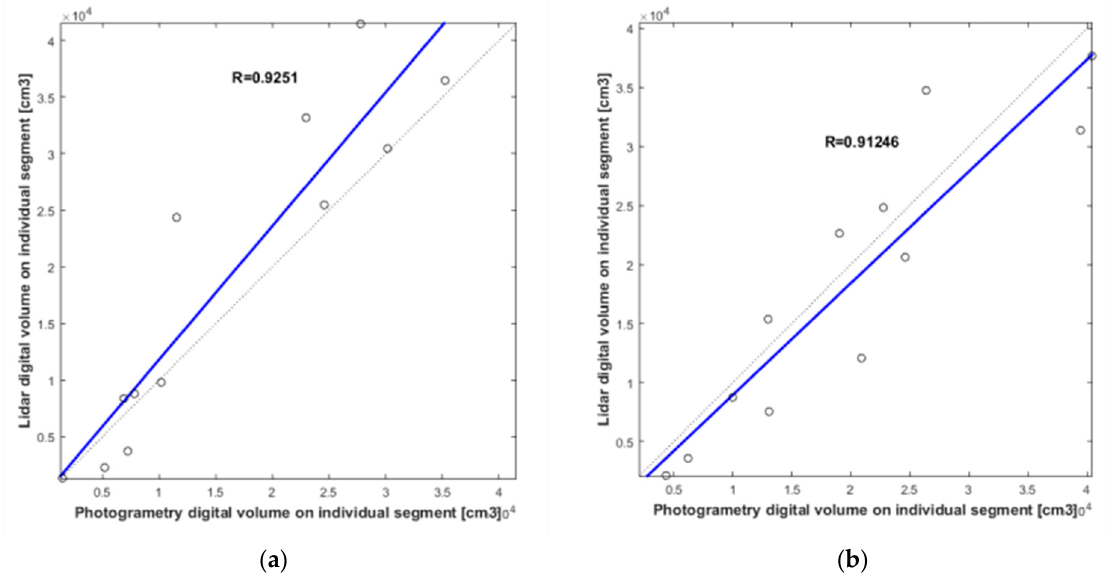
Figure 17. Correlation between digital volume (photogrammetric measurements) and digital volume (lidar measurements): ( a ) left side of canopy and ( b ) right side of canopy. The correlation was performed for all 12 segments .